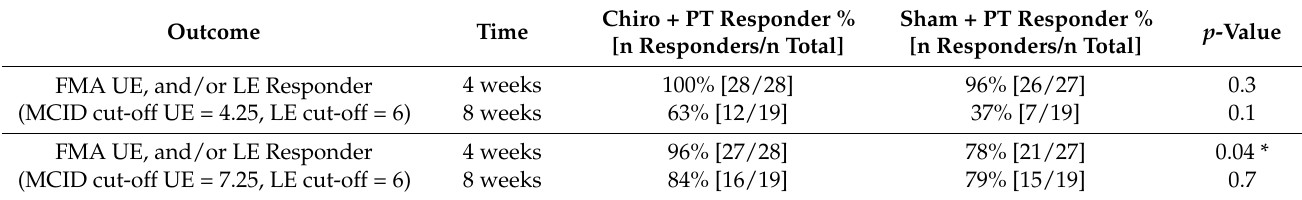
Table 3. Difference between groups in proportion of responders in the